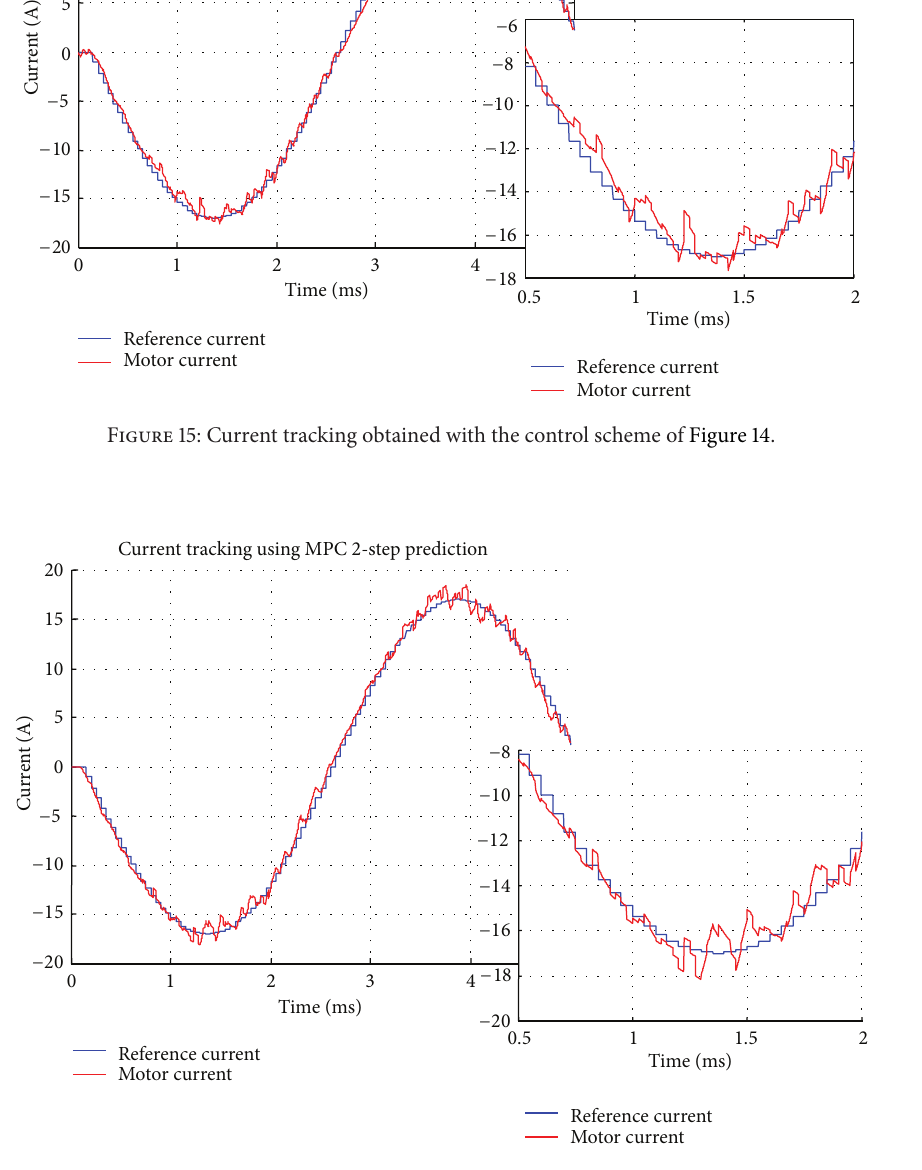
Figure 16: Current tracking obtained using an MPC (2-step prediction) with the control scheme of Figure